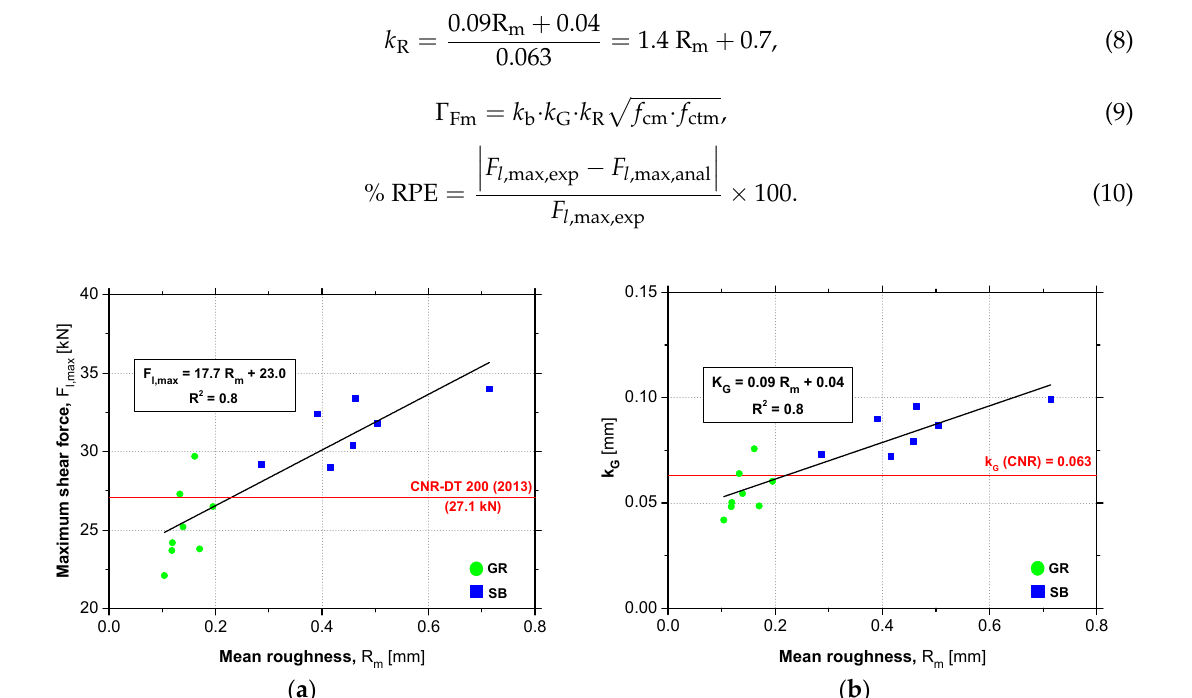
Figure 11. Relationship between the following parameters: ( a ) F l ,max vs. R m ; ( b ) k G vs. R m . Materials 2019 , 12 , 414